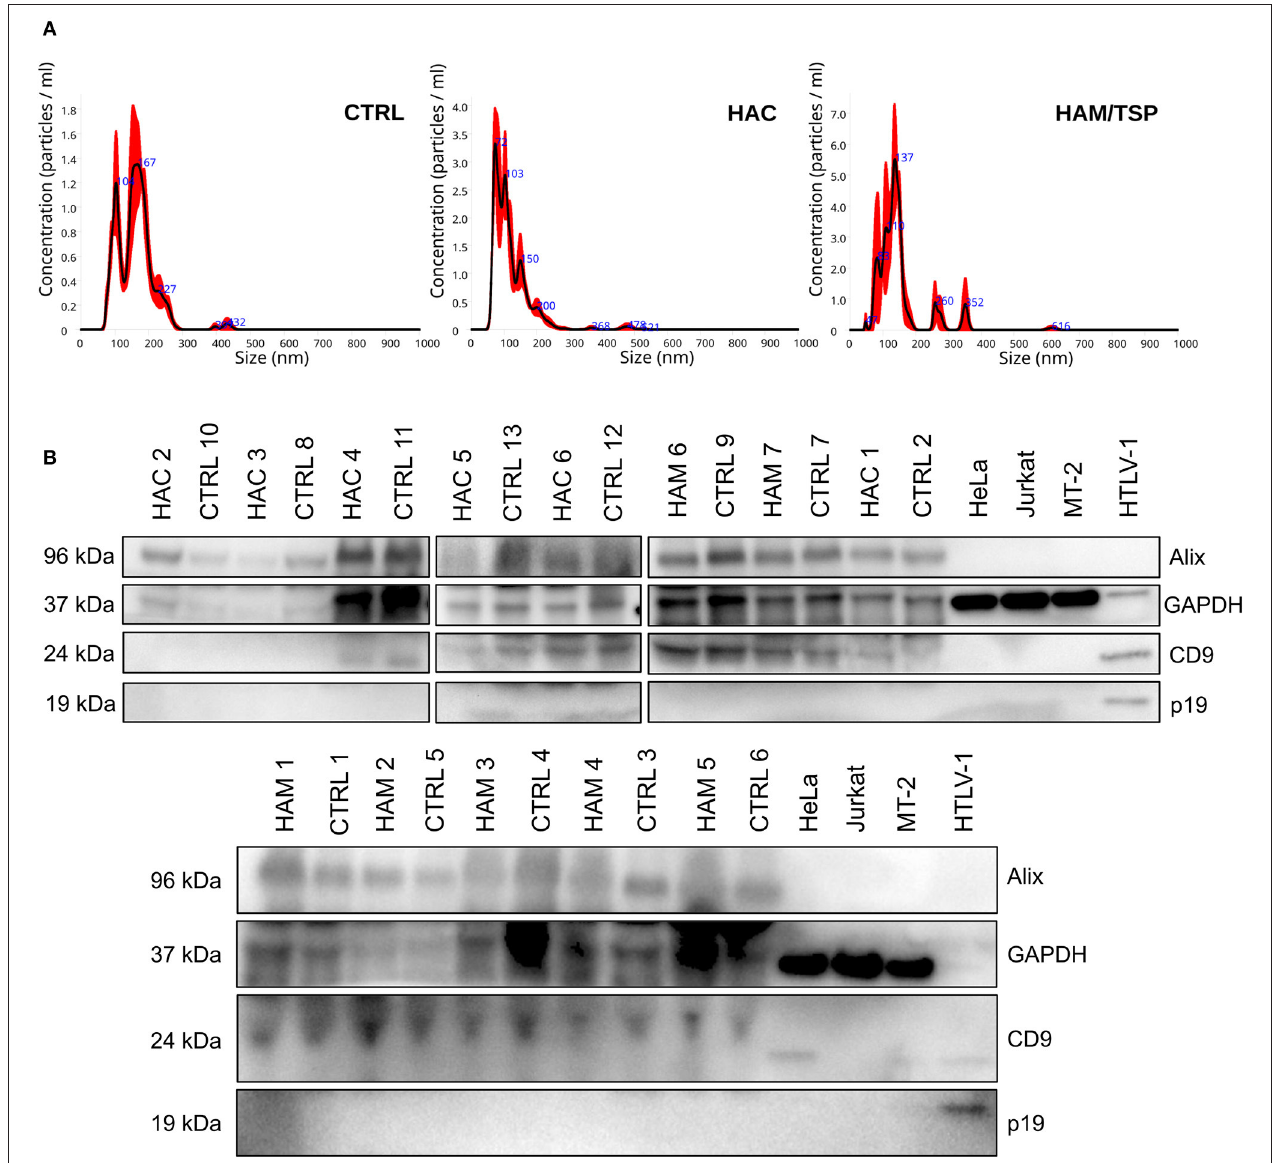
FIGURE 2 | Serum-derived small extracellular vesicles (sEVs) characterization by size and protein markers. Graphic (A) demonstrates the size distribution of suspended particles from blood donors (CTRL), HAC and HAM/TSP individuals, respectively. (B) Western Blot analysis for Alix (96 kDa), CD9 (24 kDa), p19 (kDa), and GAPDH (37 kDa) in sEV suspensions from serum samples of HAM/TSP (HAM1–HAM7), HAC (HAC1–HAC6), and control (CTRL1–CTRL13) groups. The protein extract from HTLV-1 virions was used as positive control for